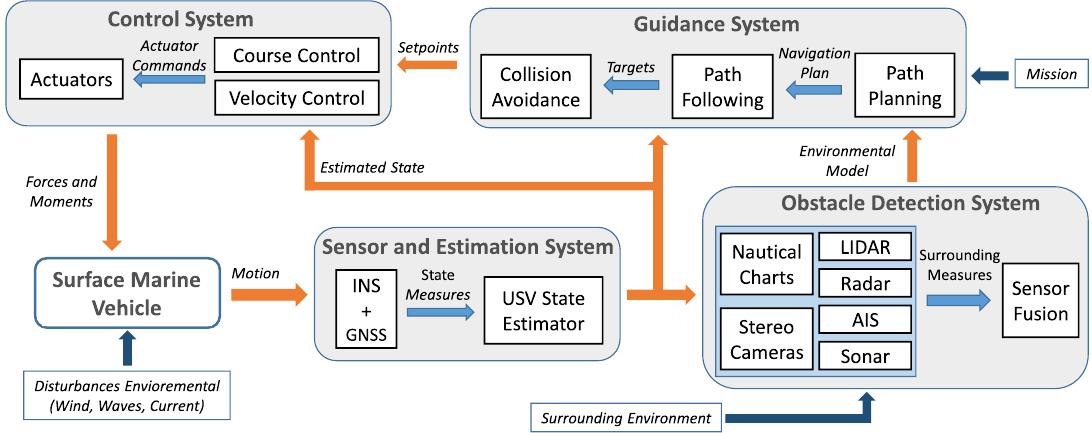
Figure 1. Interaction between the systems of an unmanned surface marine vehicle